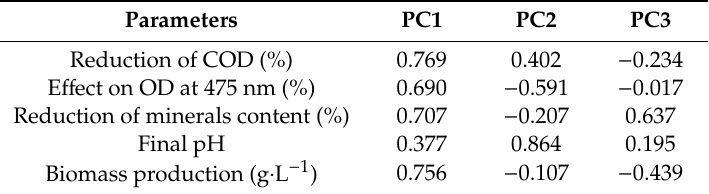
Table 3. Correlations between the parameters and principal